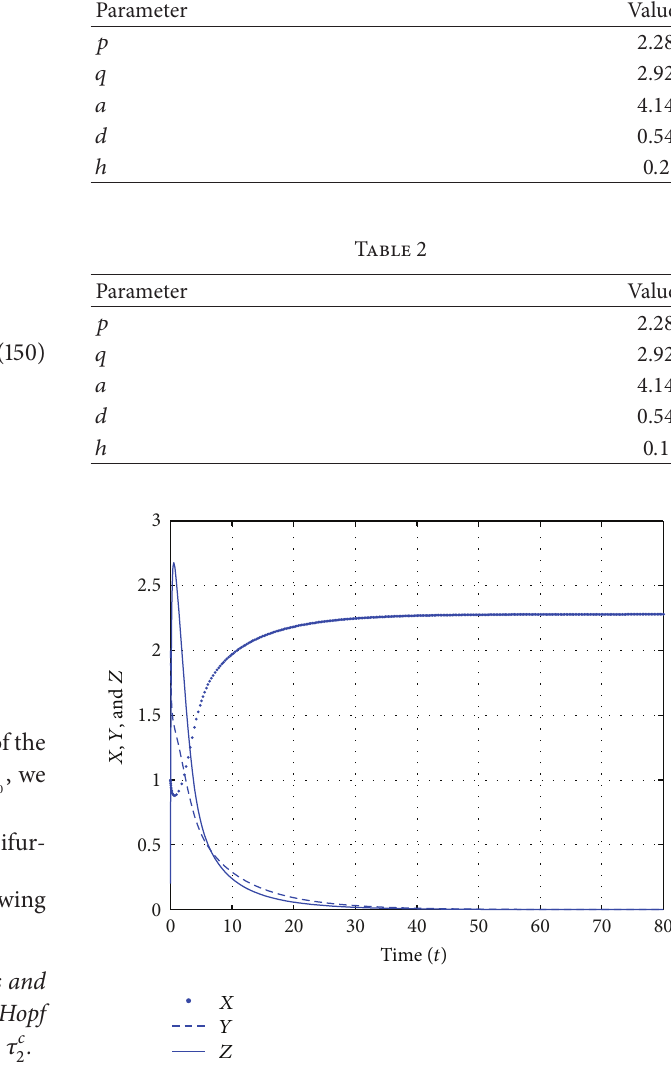
Figure 1: Time series plot of 𝑋 , 𝑌 , and 𝑍 for zero exogenous input ( 𝛾 = 0 ) with 𝑋(0) = 1 , 𝑌(0) = 2 , and 𝑍(0) = 0.2 ; parameter values are given in Table